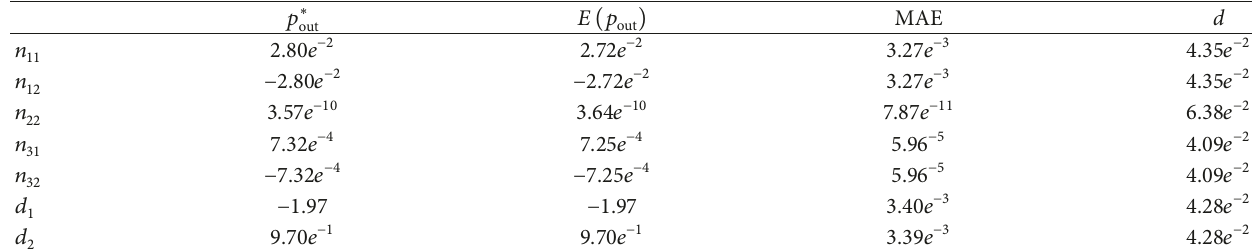
Table 3: RC to ARX transformation